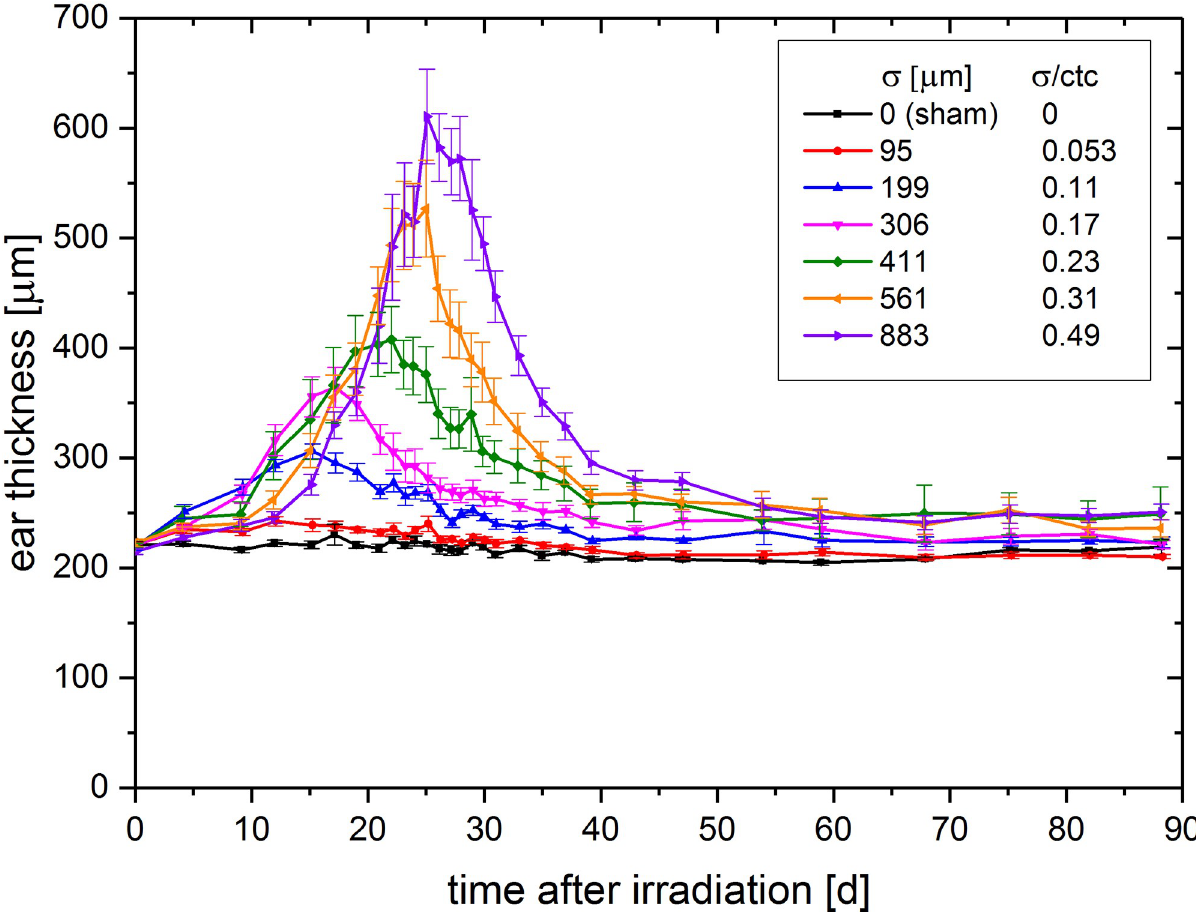
Fig 5. Mean ear thickness ( ± SEM) over time after